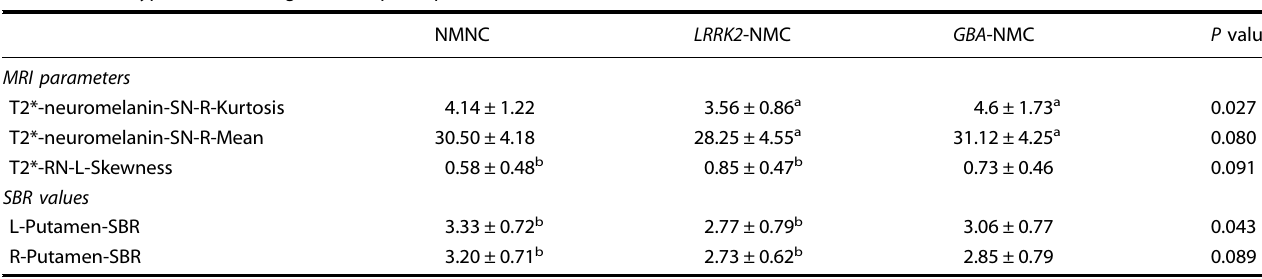
Table 5. Genotype-related changes in NM participants.